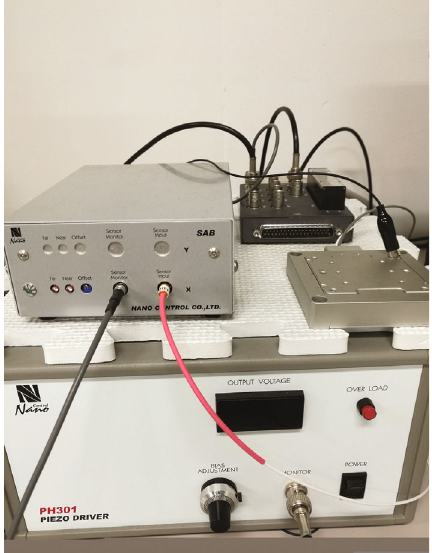
Figure 3: Piezoelectric-actuated positioning